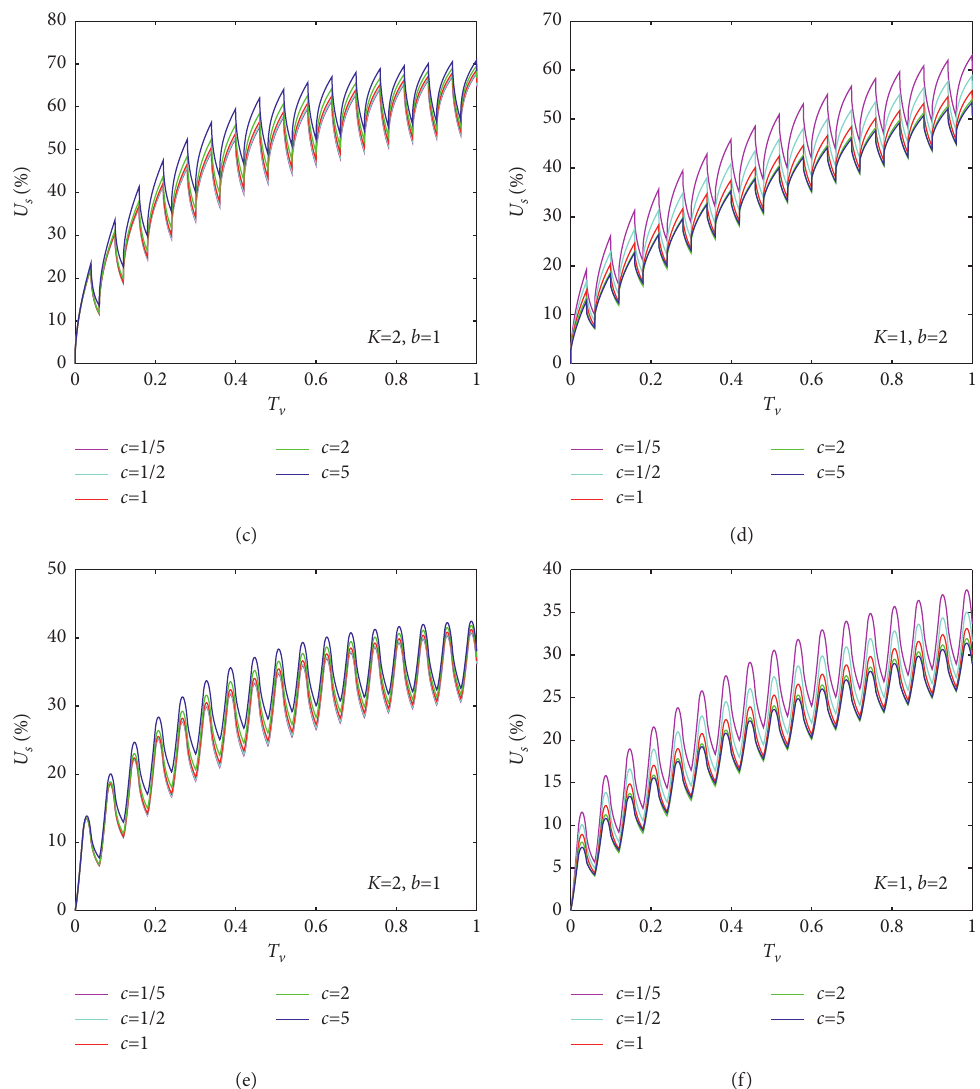
Figure 11: The variations of average degree of consolidation U